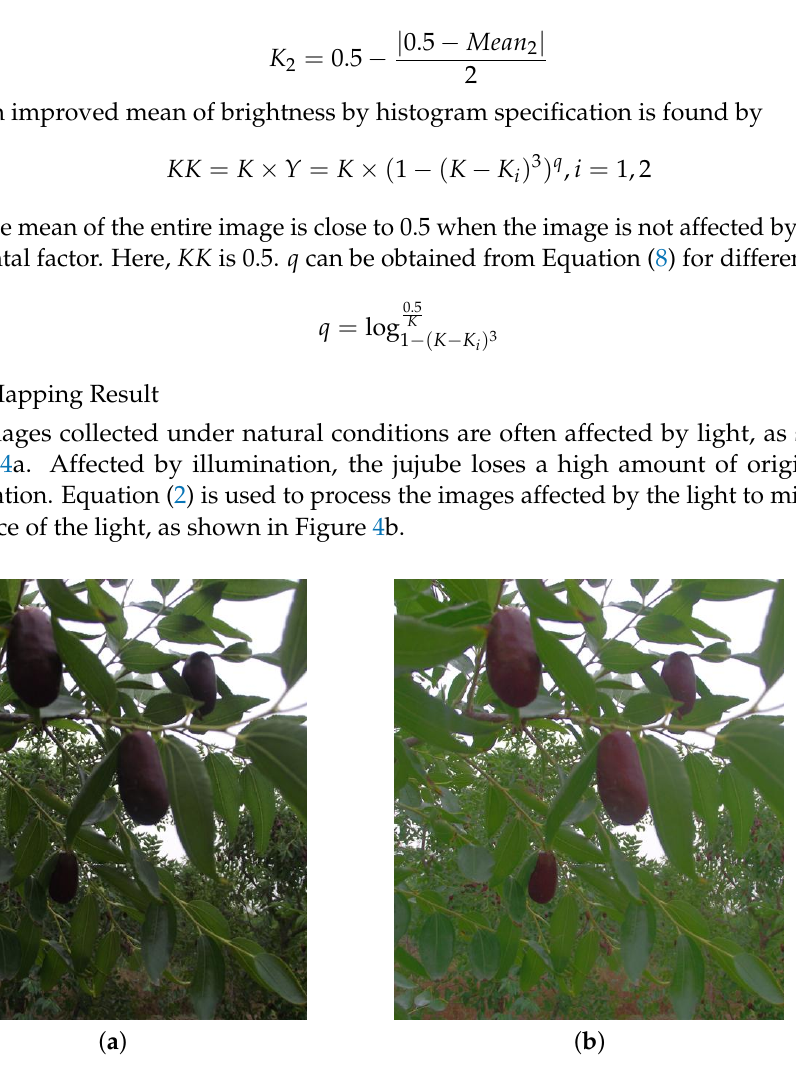
Figure 4. The result for images with severe amounts of shadow. ( a ) Original image. ( b ) Image handled by histogram